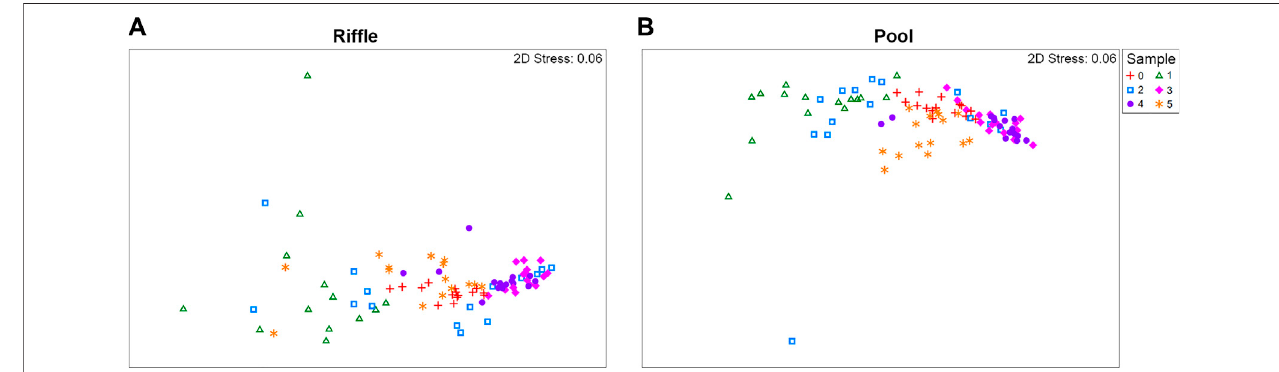
FIGURE 5 | Non-metric multidimensional scaling (NMDS) of macroinvertebrate densities in downstream drift samples based on the Bray Curtis Similarity Index for the habitats rif fl e (A) and pool (B) . Crosses: sample 0 — base fl ow, triangles: sample 1 — fi rst stage of the rising limb, squares: sample 2 — second stage of the rising limb, diamonds:sample3 — peak,circles:sample4 — peaktransitiontofallinglimb,stars:sample5 — post-peak.These fi guresincludeallexperimentsandeachindividualnet.